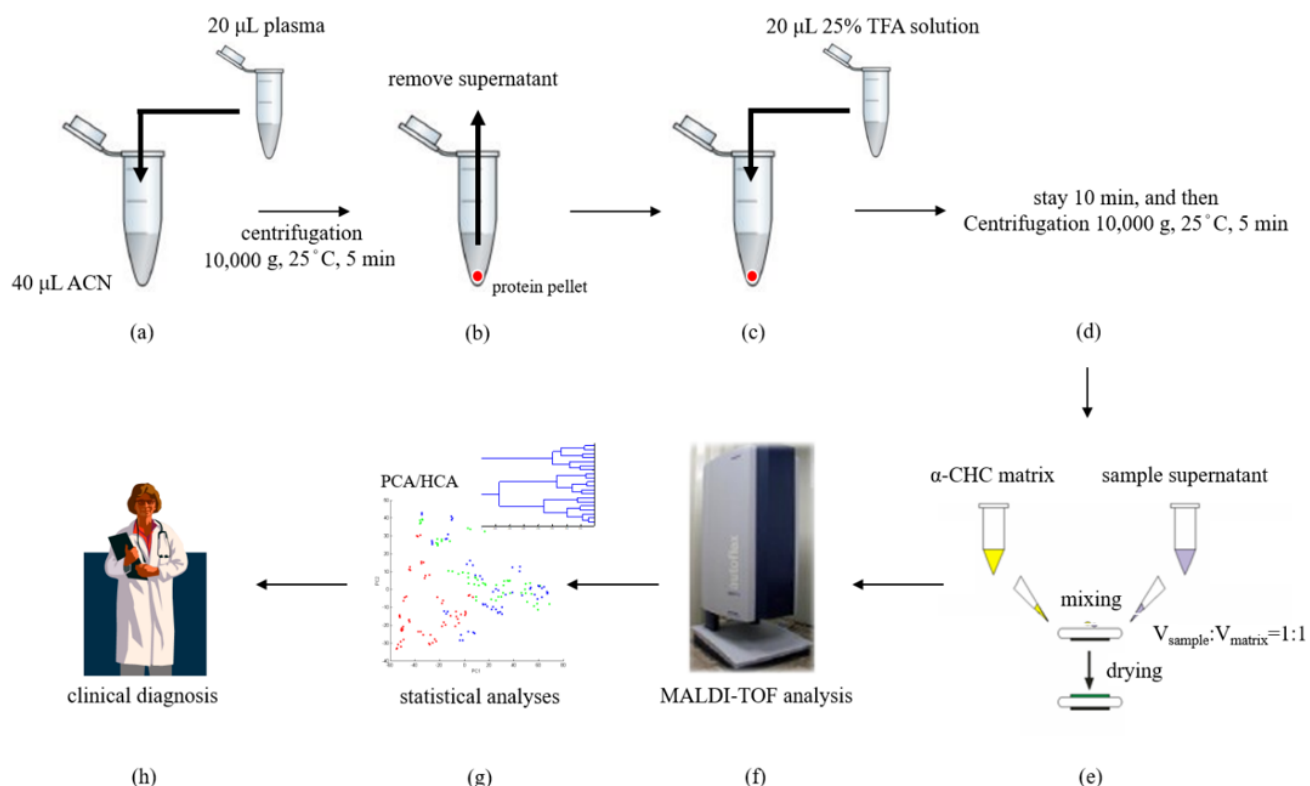
Figure 9. Overview of the MALDI-TOF analytical approaches: ( a ) an aliquot (20 µ L) of plasma sample was added into an Eppendorf tube that contained ACN (40 µ L) and ( b ) was immediately vortexed and centrifuged at 10,000 × g for 5 min at 25 ◦ C for protein precipitation. ( c ) The pellet was acid-hydrolyzed via treatment with 25% TFA (20 µ L). ( d ) After 10 min acid-hydrolysis and centrifugation (10,000 × g , 5 min, 25 ◦ C), the supernatant was collected and then ( e ) mixed with the MALDI matrix to form crystals. ( f ) The sample crystals were irradiated with a pulsed Nd-YAG laser for desorption and ionization. Acquisition of protein/peptide profiles via MALDI-TOF analysis was followed by ( g ) characterization of the plasma samples using multivariate statistical analyses to facilitate ( h ) clinical diagnosis.